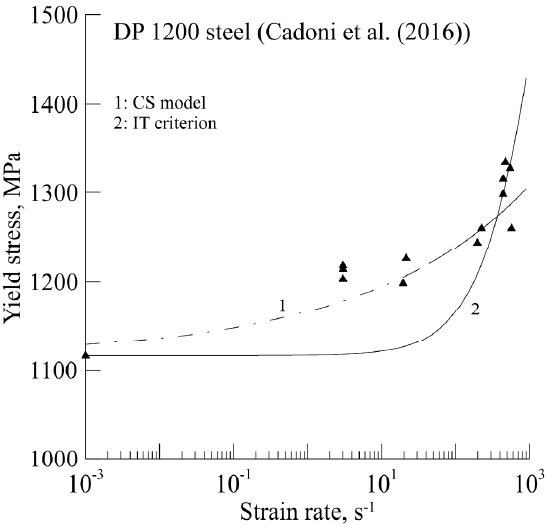
Fig. 2. Rate dependence of yield stress of DP1400 steel (data from [47]), plotted on CS model (1 line) and IT criterion (2 line).